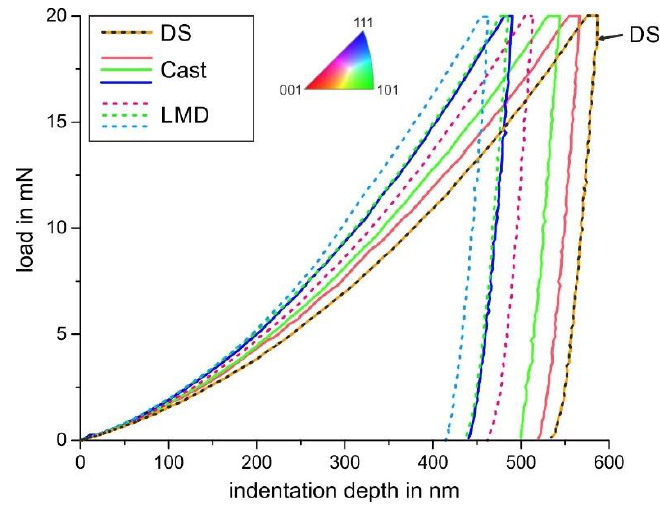
Figure 14. Load-displacement curves of the investigated specimens and crystallographic orientations.